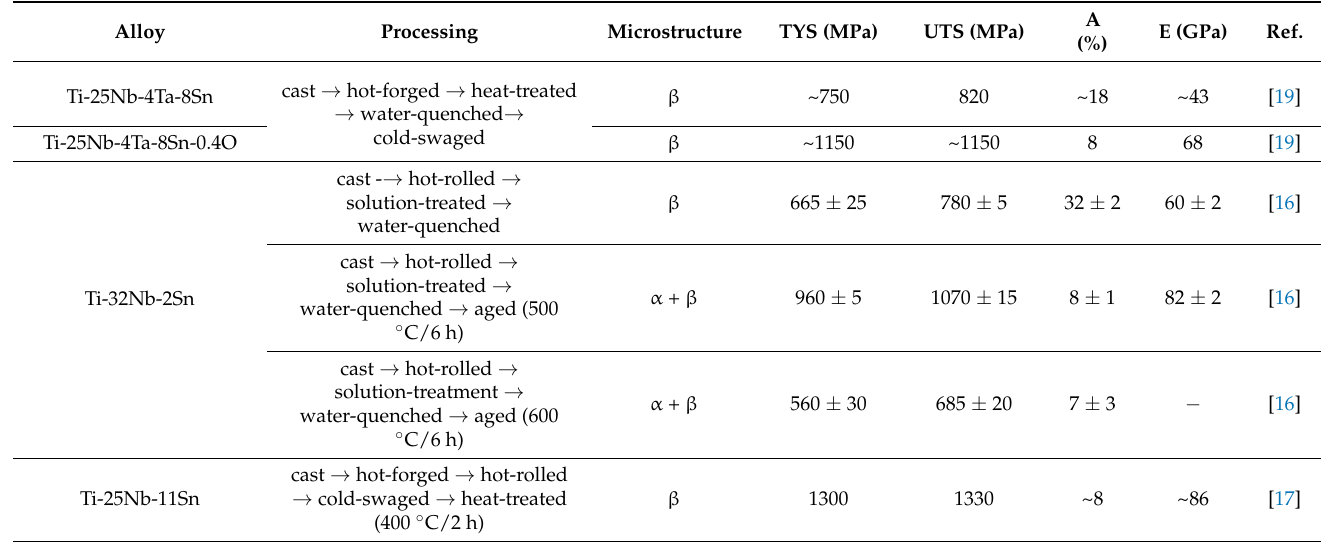
Table 3. Comparison of mechanical properties of selected alloys in